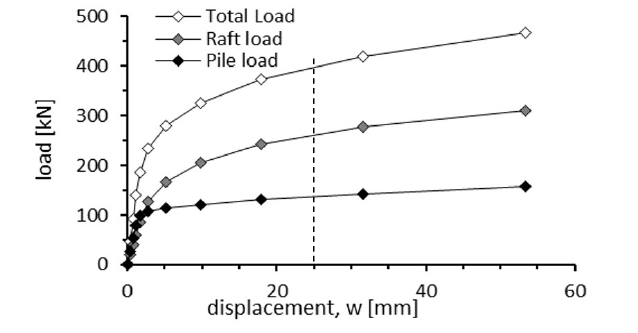
Figure 22. Load-settlement curves for case 15 - L=6m; t=0.3m